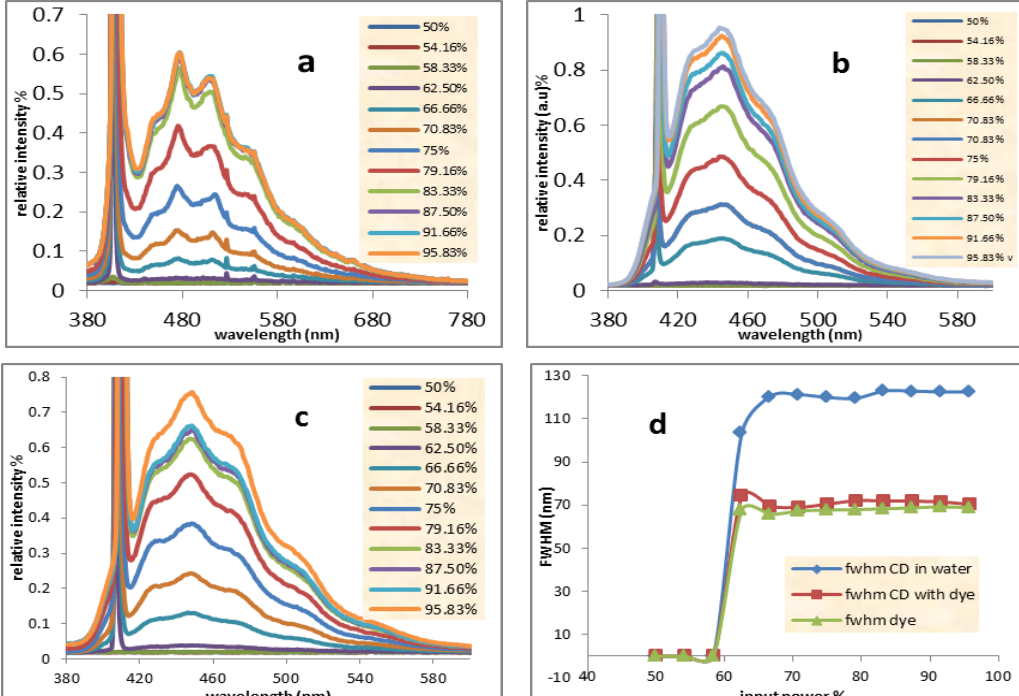
Fig.7: The fluorescence spectra for a- CQDs b- Stilbene 420 dye c- CQDs with Stilbene 420 dye and d- relationship between the input power % to FWHM for all three type in